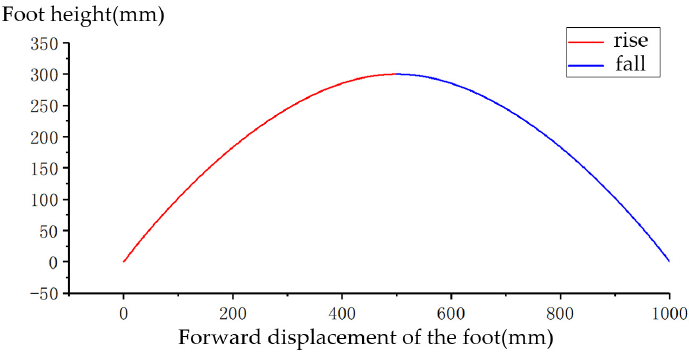
Figure 12. Foot trajectory.